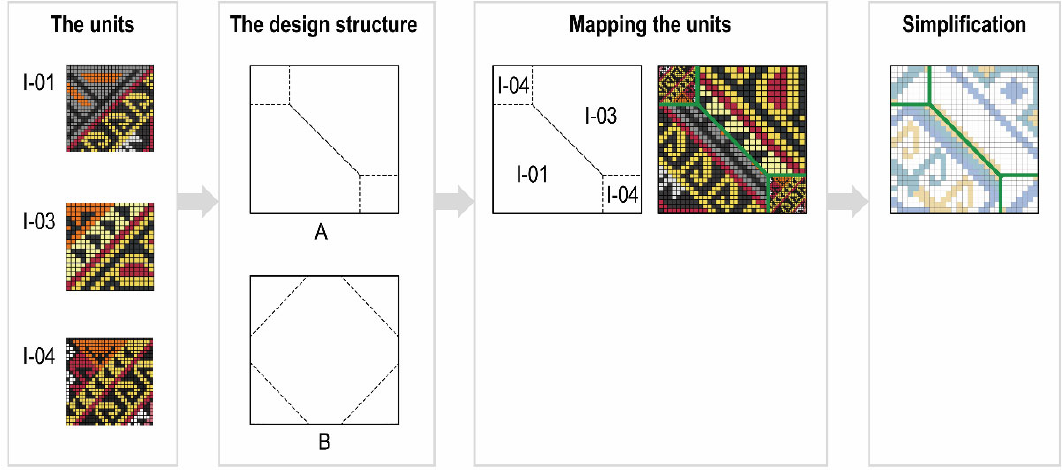
Figure 9. Mapping asymmetric units in the design structure, followed by simplification. (Illustration by Kunkhet and Chudasri).